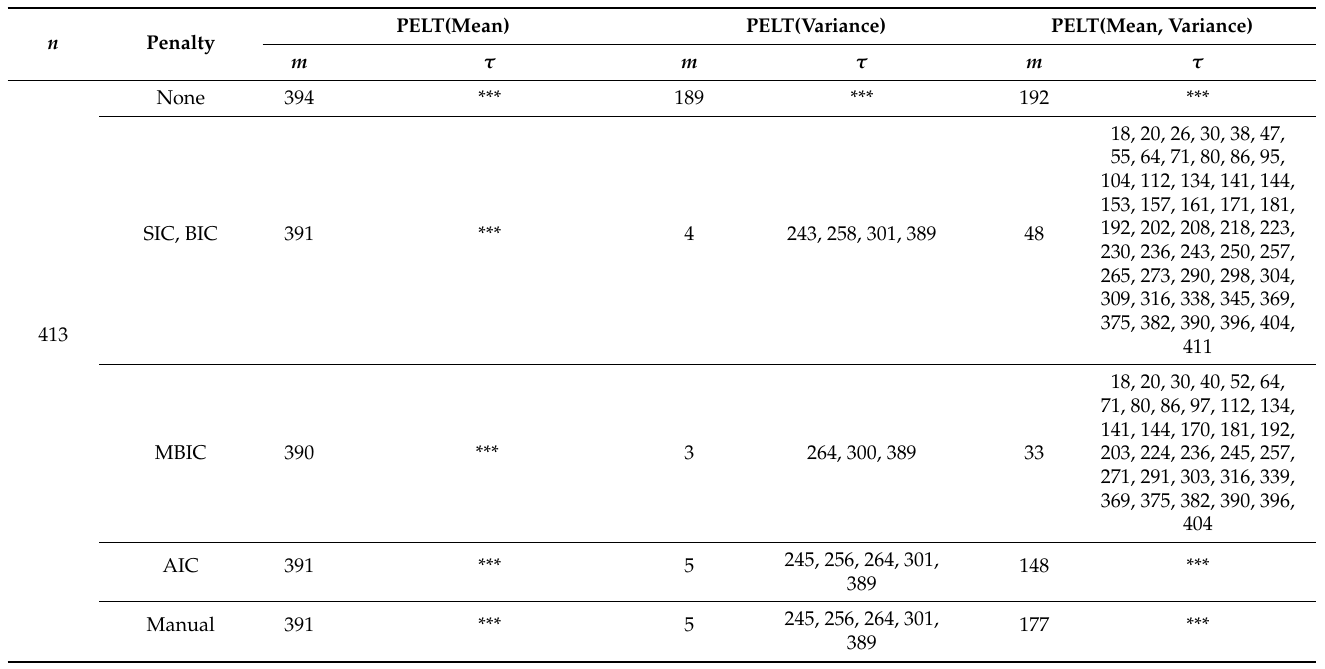
Table A15. PELT Algorithm Result for Poland’s COVID-19 Daily